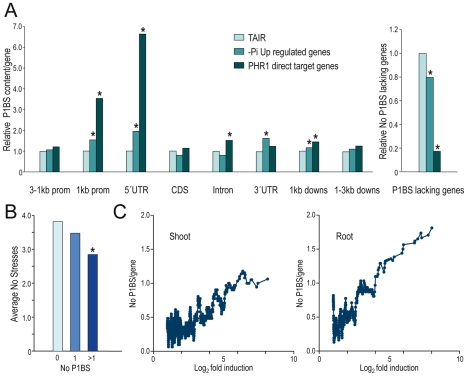
P1BS distribution over different gene parts of PHR1 direct targets and Pi starvation-responsive genes.(A) P1BS content per gene in different gene parts (distal promoter region, 3-1 kb prom; proximal promoter region, 1kb prom; 5′UTR, coding region, CDS; Intron; 3′UTR; proximal downstream region, 1 kb downs; distal downstream region, 1–3 kb downs) (left) and proportion of genes lacking P1BS in any of these gene parts (right). The P1BS content of the average Arabidopsis genes, represented in the Affimetrix chip used in transcriptomic analyses, is taken arbitrarily as 1. (B) Average number of other stresses in which Pi starvation-induced genes are also induced relative to the number of P1BS motifs in the 1 kb proximal promoter region. Data for induction by other stress types were obtained from 28 stress conditions for which transcriptomic data were available in the GENEVESTIGATOR database (https://www.genevestigator.com) [30]. Asterisks in A and B represent significant differences (p<0.01 using the χ2 test). (C) Relation between the number of P1BS motifs in the 1 kb promoter proximal region and log2
x-fold induction. The number of P1BS/gene (No P1BS/gene) was calculated as the average content of P1BS motifs over successive sets of 30 genes, measured at a one-gene interval, ordered according to inducibility by Pi starvation.